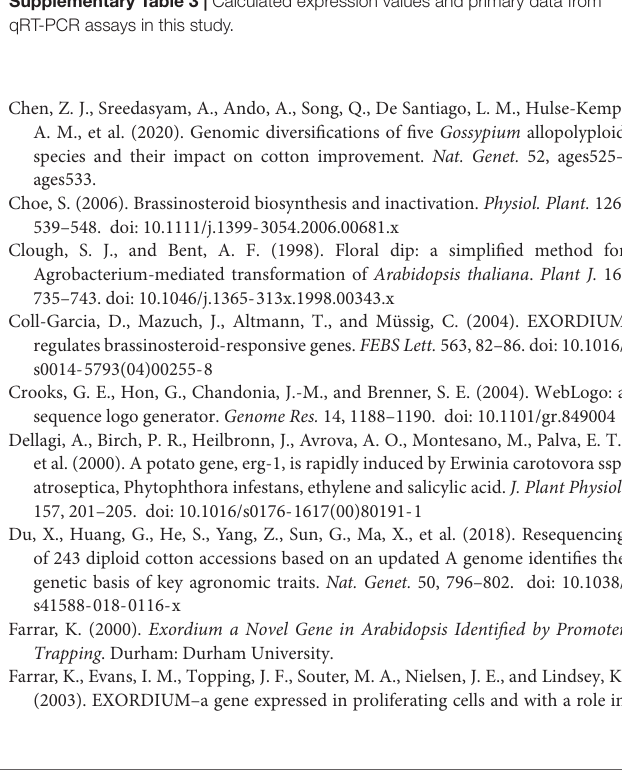
Supplementary Figure 1 | Phylogenetic analysis of EXO protein sequences from four cotton species. Supplementary Figure 2 | Chromosomal locations of predicted GhEXO gene family members in the G. hirsutum genome. Supplementary Figure 3 | Gene structure analysis of the GhEXO family in G. hirsutum . (A) Protein motif distribution patterns of GhEXO proteins. (B) Intro/exon structures of the GhEXO genes. Supplementary Figure 4 | The expression levels of six other GhEXO genes in the GhEXO7_At silenced plants. Student’s t -test: ∗ p < 0.05, ∗∗ p < 0.01. Supplementary Figure 5 | Multiple sequence alignments of conserved motif data from Arabidopsis , rice, and G. hirsutum . Supplementary Figure 6 | Statistical analyses of leaf length (A) , leaf width (B) , and plant height (C) vector control and VIGS: GhEXO7_At plants. Student’s t -test: ∗ p < 0.05. (D) Mature fiber length in the vector control and VIGS: GhEXO7_At plants. Comparison of total root length (E) and root fresh weight (F) of